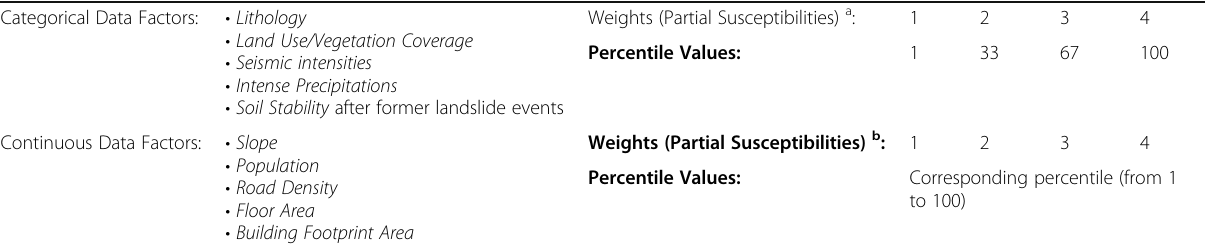
Table 4 Conversion table of categorical data from weights encoding to percentile discretization, and continuous data to percentiles Categorical Data